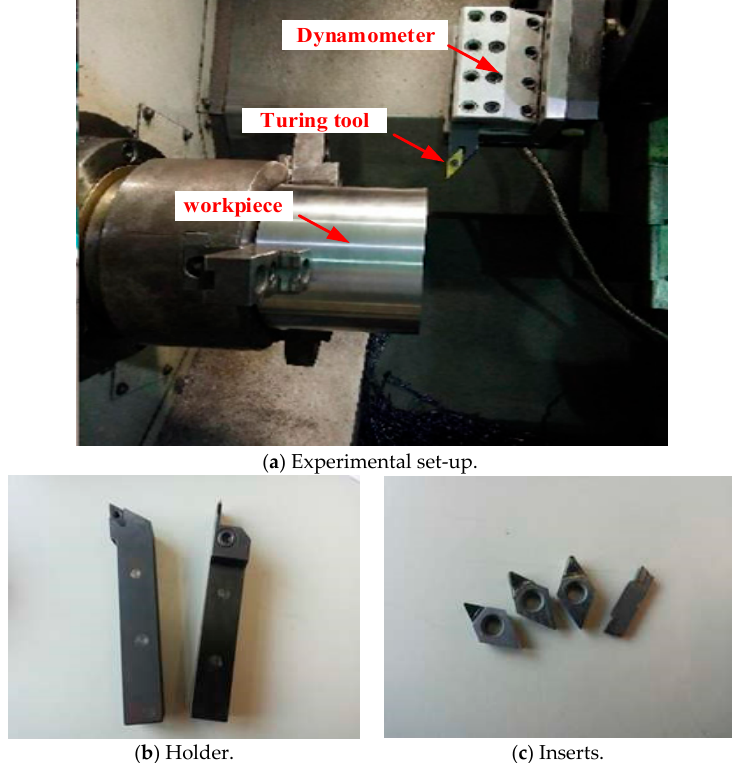
Figure 3. Schematic illustration of the experimental set-up for turning 17vol.% SiC p /2009Al composites.